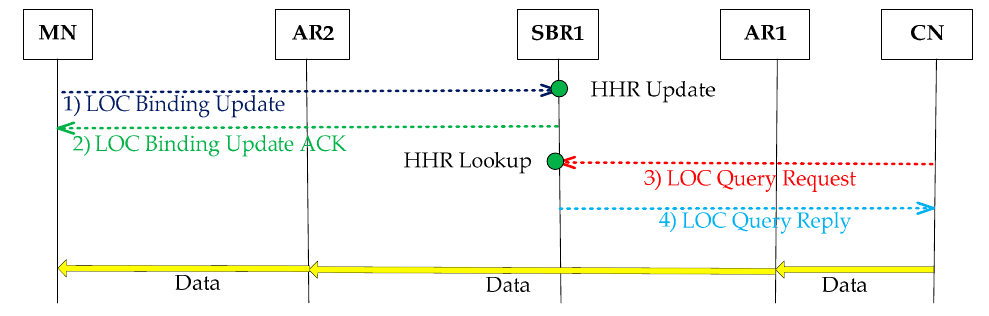
Figure 6. Binding and query operations for non-roaming.